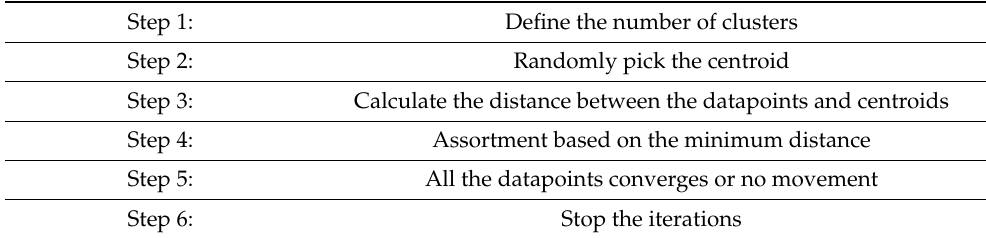
Table 2. Basic steps for the classical k-means algorithm [30,31].